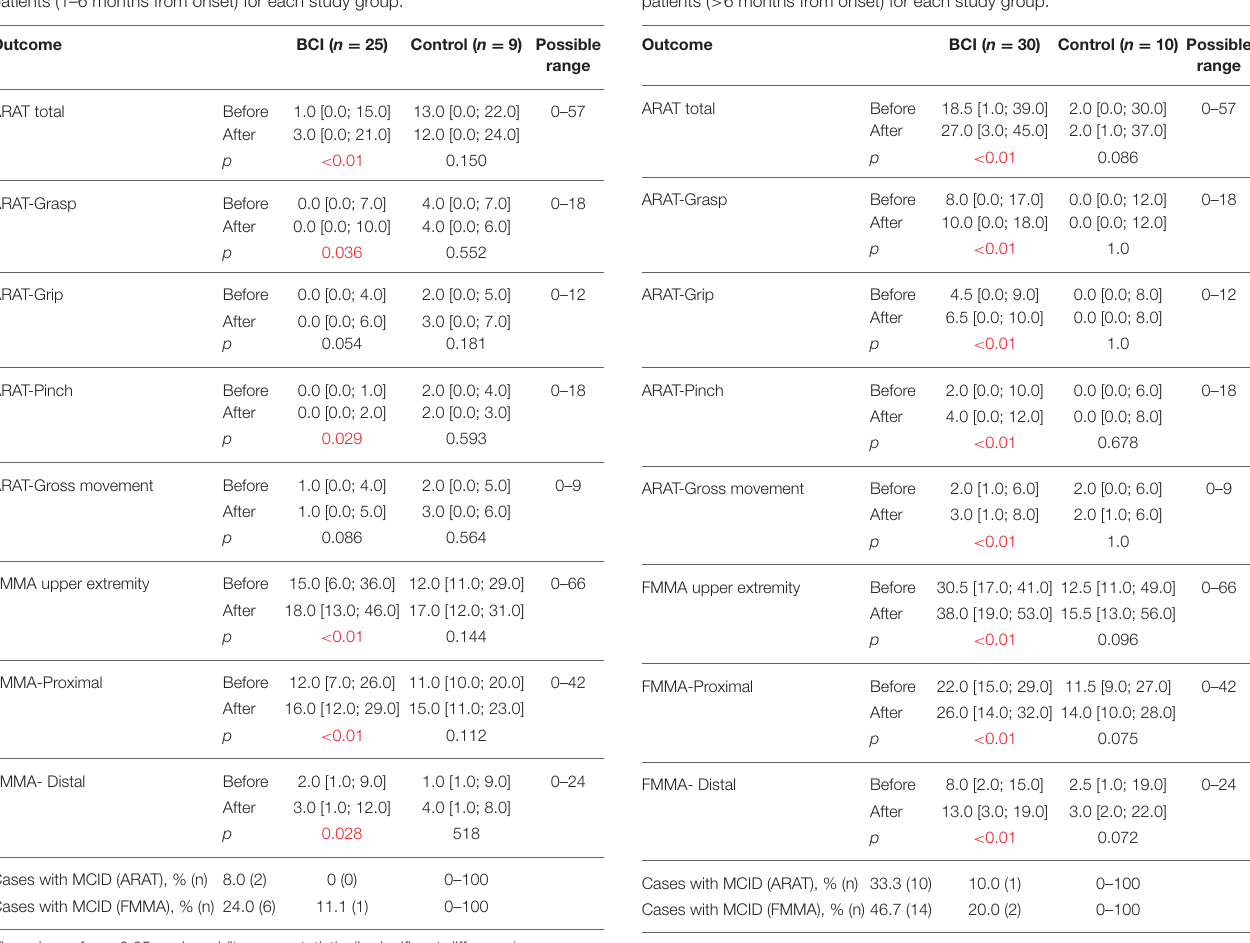
TABLE 5 | Efficacy measures by ARAT and FMMA scores in chronic stroke patients ( > 6 months from onset) for each study group. Outcome BCI ( n = 30) Control ( n = 10) Possible range ARAT